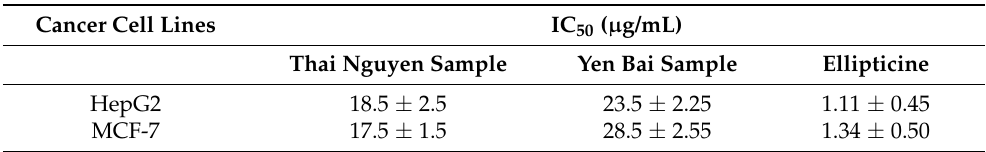
Table 5. Anti-cancer activities of C. verum bark EOs extracted by water distillation method. The values represent the averages of three replicates and statistical differences are considered at p -value <